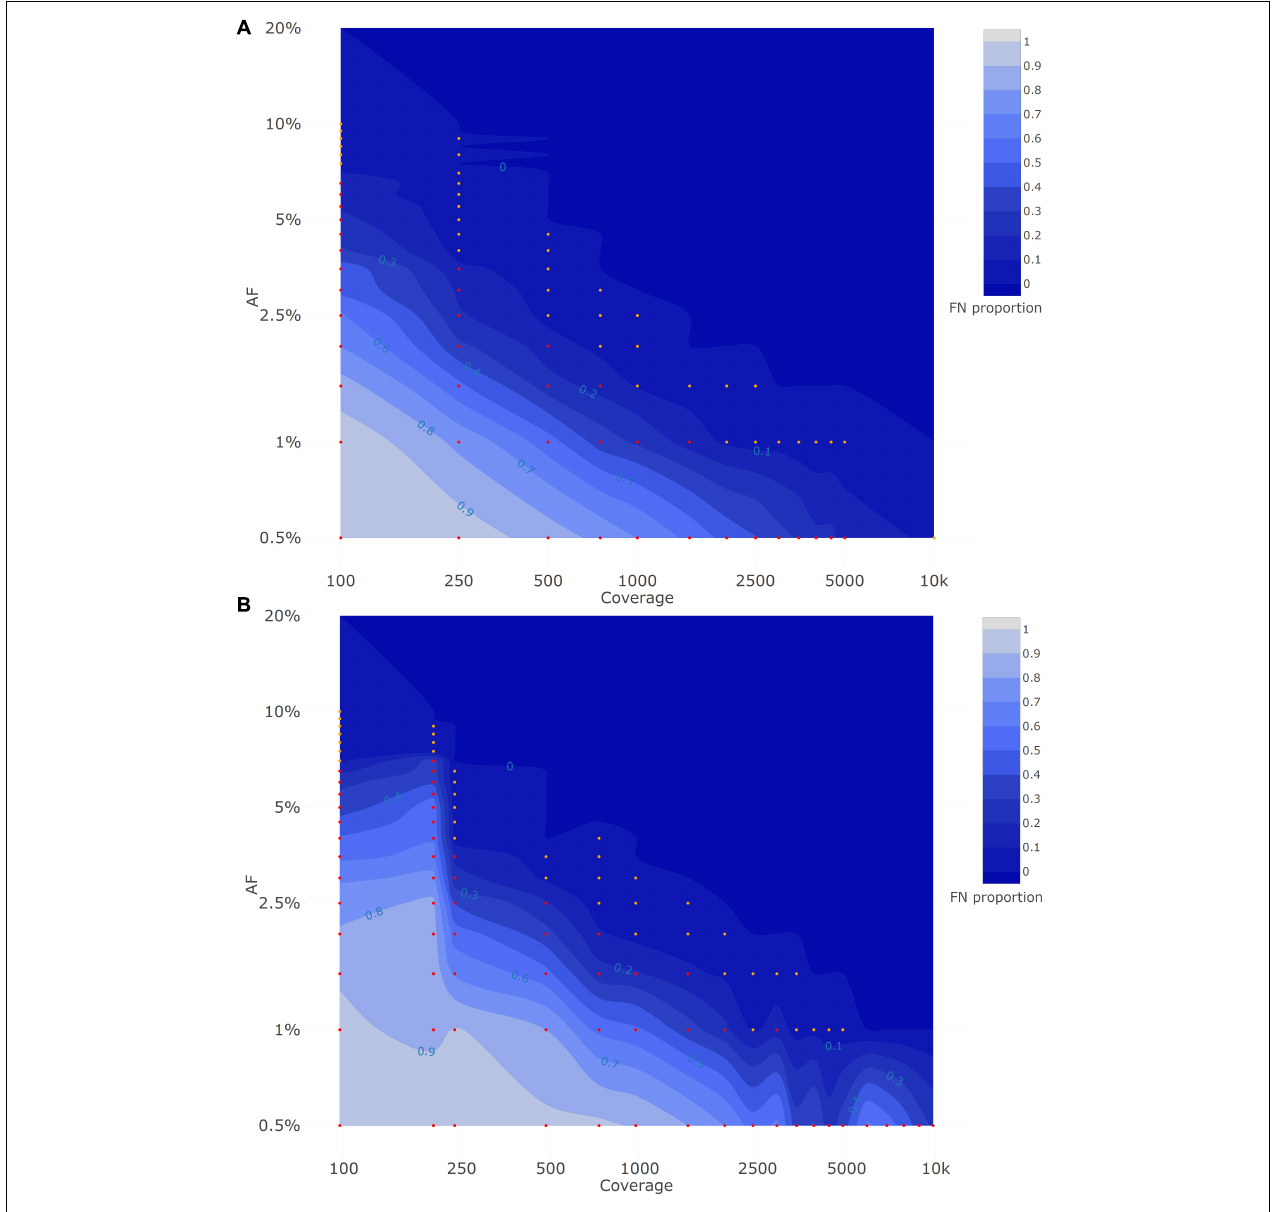
FIGURE 2 | Qualitative evaluation of Dataset 1 (A) and Dataset 2 (B) based on false negative proportions per condition until a targeted mutant AF of 20%. Orange and red dots represent conditions with a FN proportion between 0 and 0.1, and between 0.1 and 1, respectively. The percentage of FN is colored ranging from 0 (dark) to 1 (light) in intervals of 0.1 as extrapolated using a contour plot in the R package plotly (Sievert, 2020) (actual FN proportions are presented in Table 3 for Dataset 1 and Table 4 for Dataset 2). Results for targeted mutant AF values > 20% are presented in Supplementary Figure 1 for Dataset 1 and Supplementary Figure 2 for Dataset 2. Both the X - and Y -axis follow a logarithmic